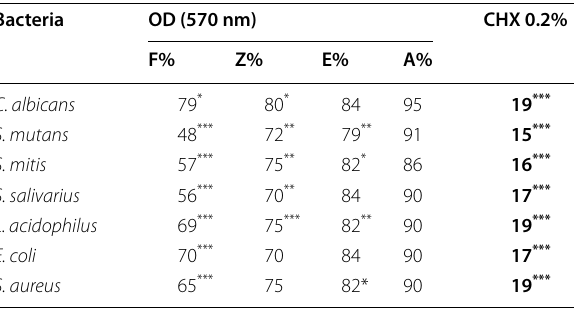
Table 5 The biofilm formation percentages of species treated with samples of A, E, Z, F, and chlorhexidine 0.2%